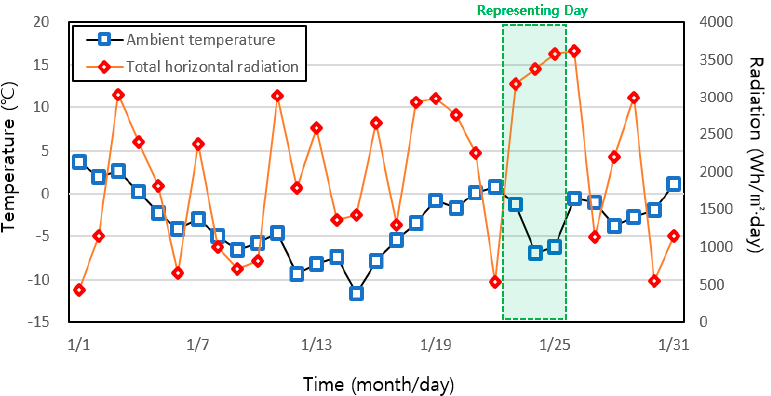
Figure 16. Ambient temperature and solar radiation in January.